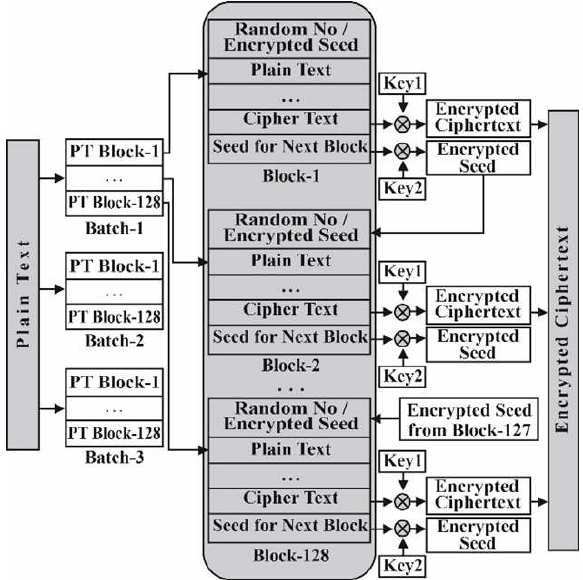
Figure 3. Block diagram of proposed